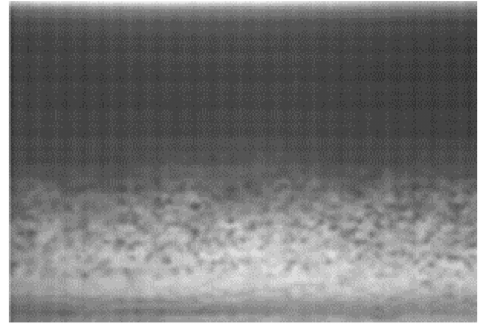
Figure 18. Flow pattern at U oil = 0.122 m / s, U water = 0.284 m / s—experiment